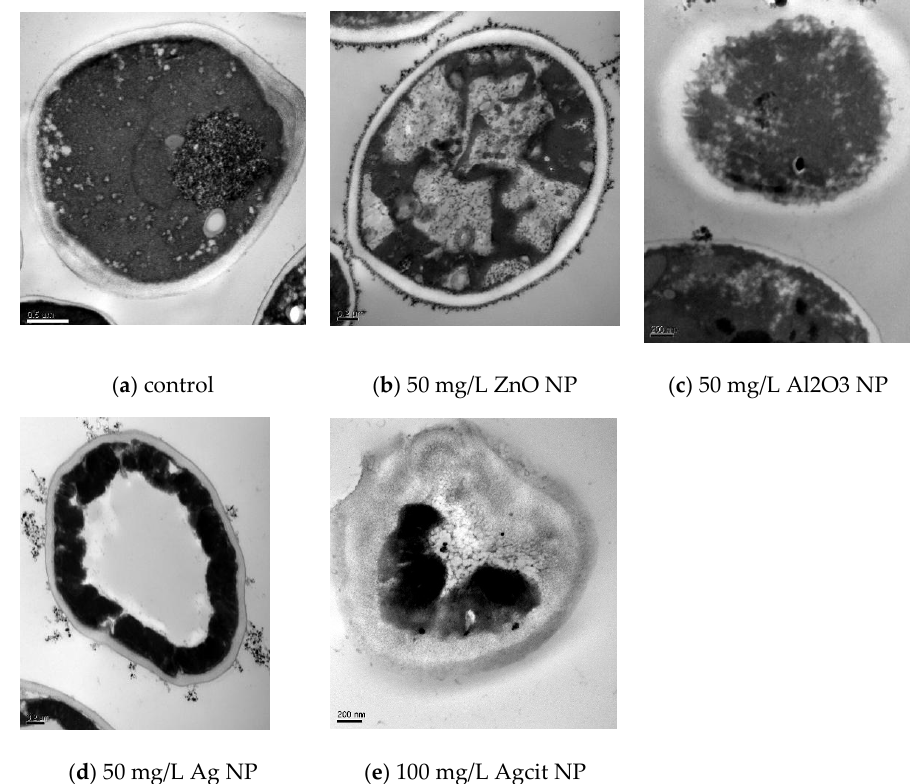
Figure 3. Representative transmission electron microscopic images showing distribution of nanoparticles in